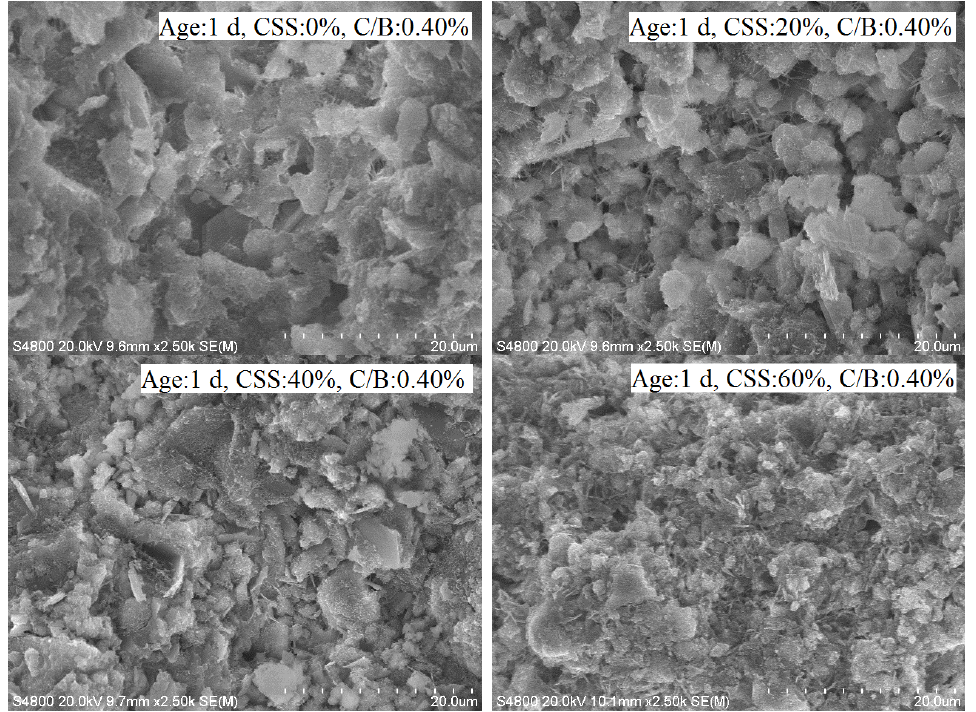
Figure 8. Flexural strength of the sample.